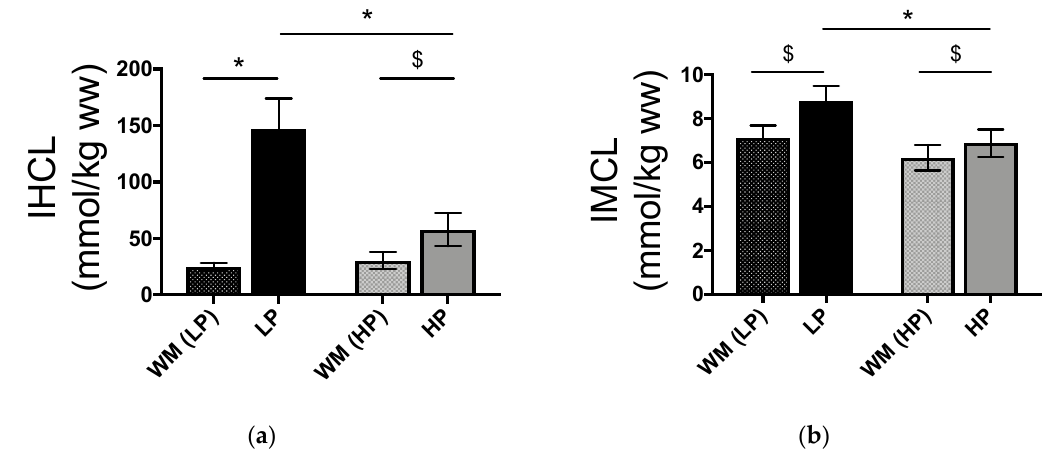
Figure 3. Intrahepatocellular (IHCL) ( a ) and intramyocellular (IMCL) lipids ( b ) in response to weight maintaining diet (WM LP-HF and WM HP-LF ) and overfeeding with LP-HF and HP-LF. n = 12; significant responses from WM LP-HF and WM HP-LF were measured by 2-way ANOVA for repeated measures with interaction. *: p < 0.001, interaction overfeeding × protein/fat content. $: p < 0.005, Tukey post hoc tests.